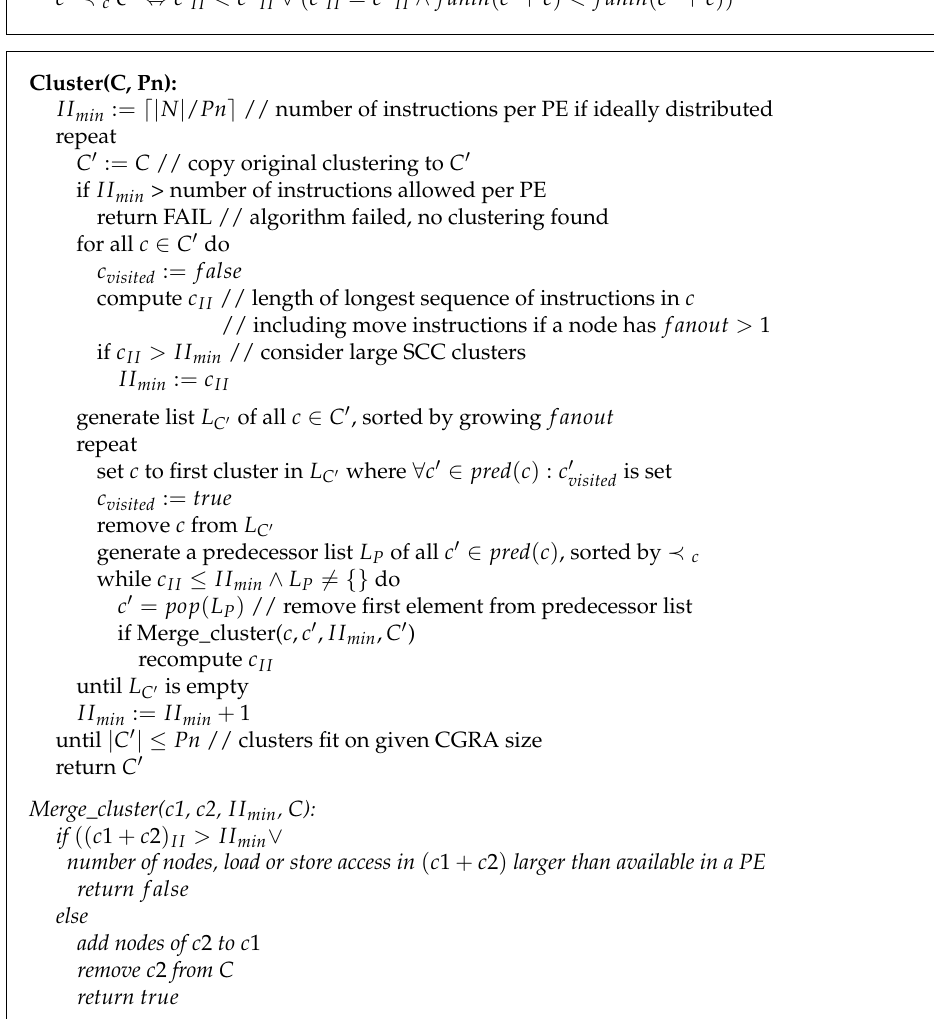
Figure 5. Clustering Heuristic Cluster .